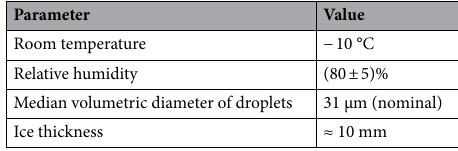
Table 3. Icing wind tunnel parameters for ice